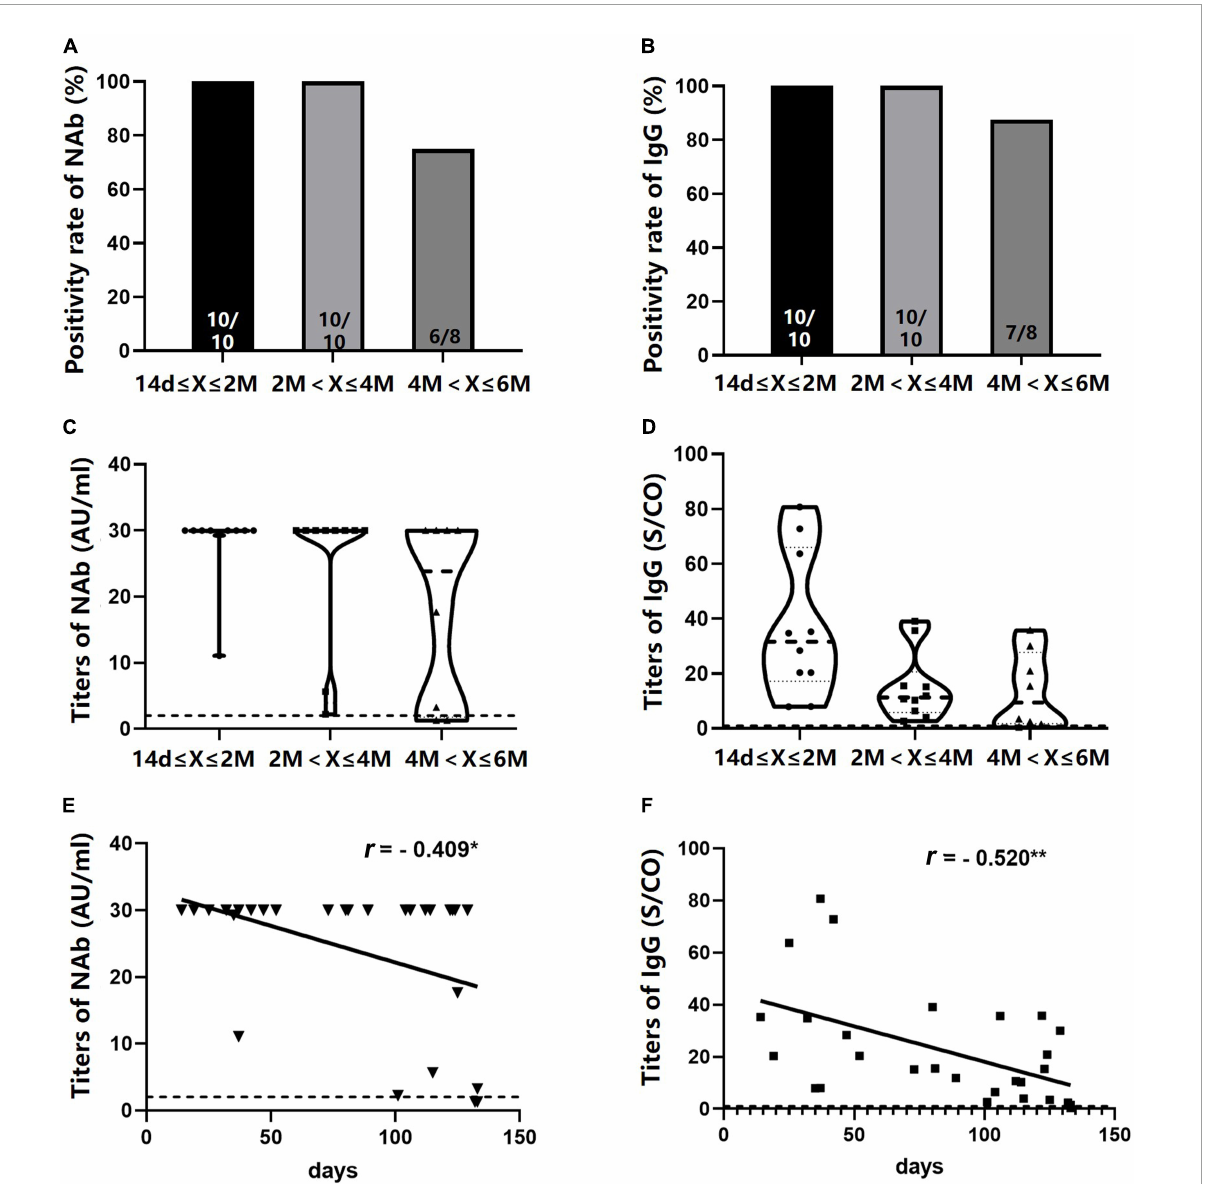
FIGURE8 Seropositivity rates and titers of NAb and immunoglobulin G (IgG) in NA-treated patients after the booster dose. (A,B) NAb and IgG positivity rates at different time intervals after the booster dose. (C,D) NAb and IgG antibody titers at different time intervals after the booster dose. (E,F) A negative correlation was observed between NAb and IgG titers and the number of days after the booster dose. * P < 0.05; ** P < 0.01; n1/n2 in bars, positive cases/all cases; dotted line, cut-off value; NAb, neutralizing antibody; NAs, nucleos(t)ide analogs. Symbols in C and D: • , antibody values in 14 days-2 months; (cid:3) , antibody values in 2–4 months; (cid:78) , antibody values in 4–6 months. (cid:72) in E: titers of NAb; (cid:3) in F, titers of